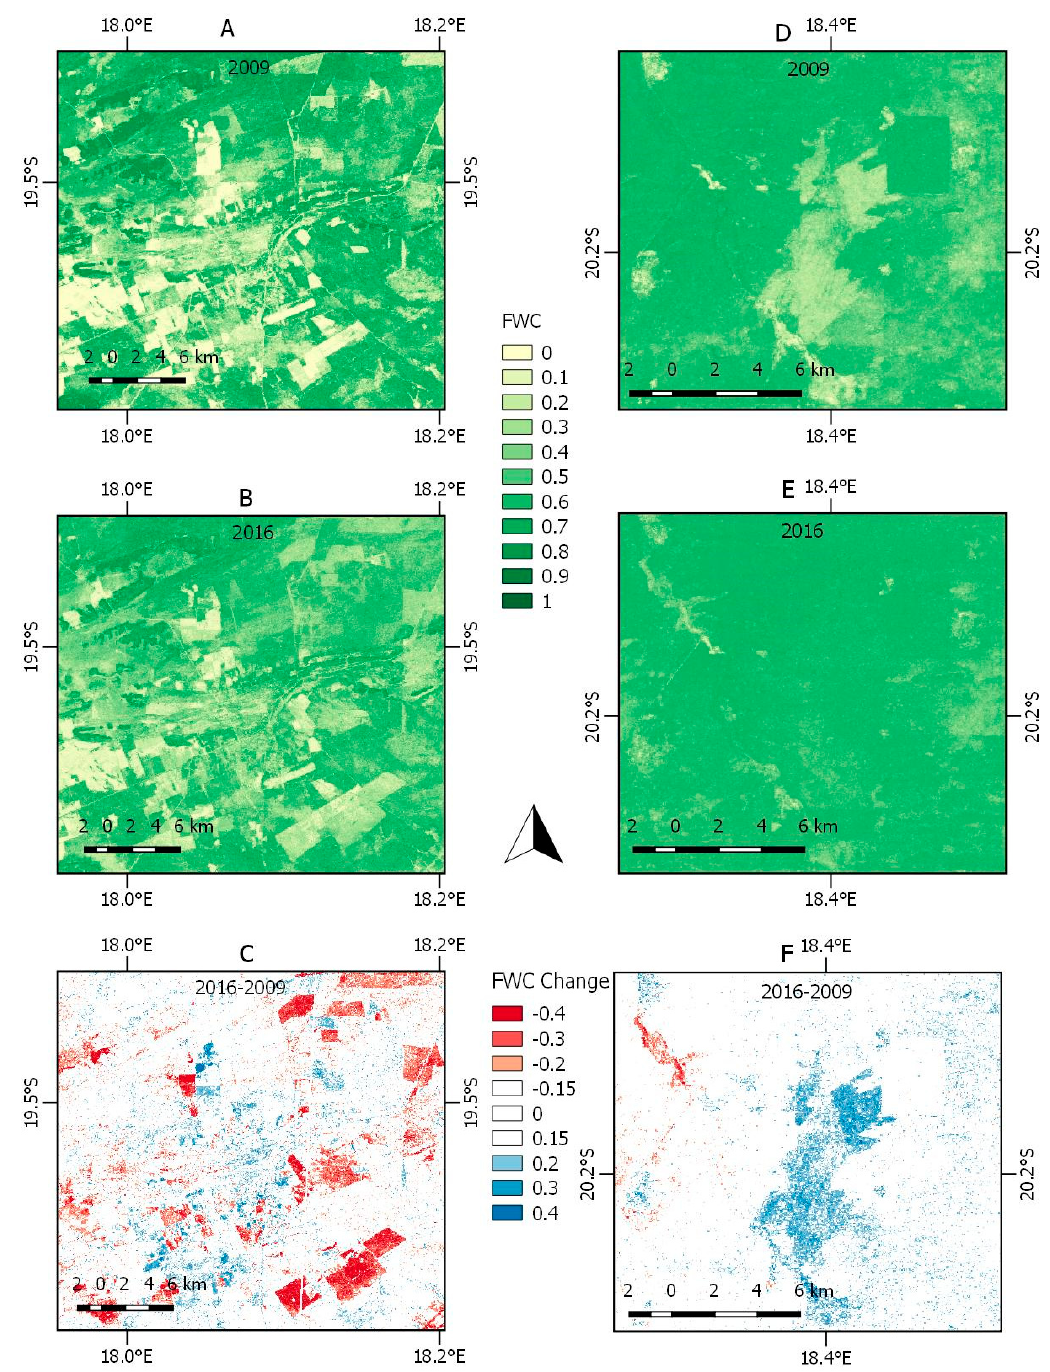
Figure 14. Examples of local patterns of fractional woody cover change maps. ( A ) FWC2009 50mSAR + MAP of area south of Tsumeb area in 2009 and ( B ) FWC2016 50mSAR + MAP . ( C ) Corresponding FWC ∆ 2016–2009 showing distinct areas of debushing (FWC ∆ < − 0.3) and areas where FWC has increased (FWC ∆ > 0.2), following debushing prior to 2009. ( D ) FWC of area north of Gobabis where a wildfire reduced the FWC in 2009 after which the area experienced an increase in FWC up to 2016 ( E , F ).